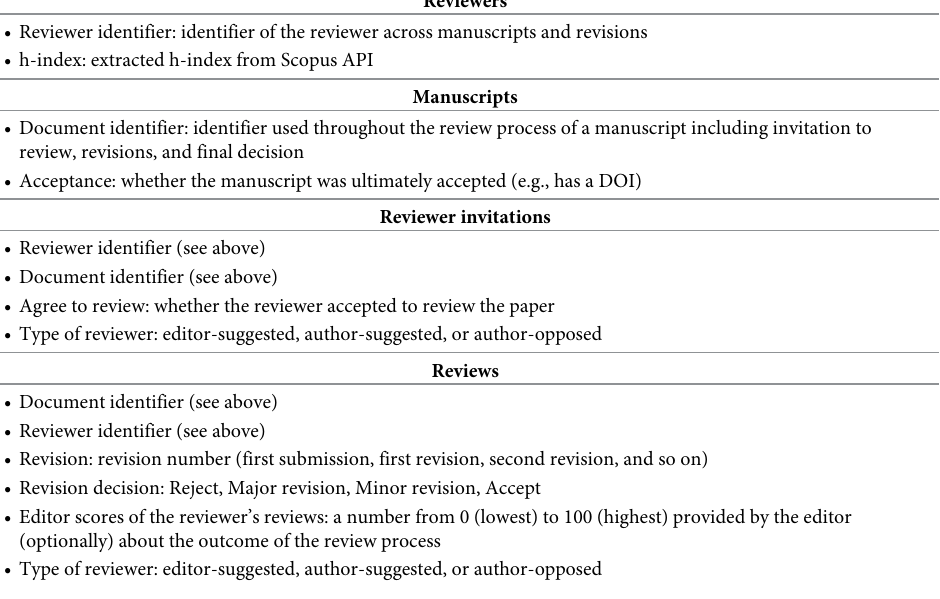
Table 1. Sets of variables analyzed in this article. Some identifiers are shared across these sets of variables and noted when